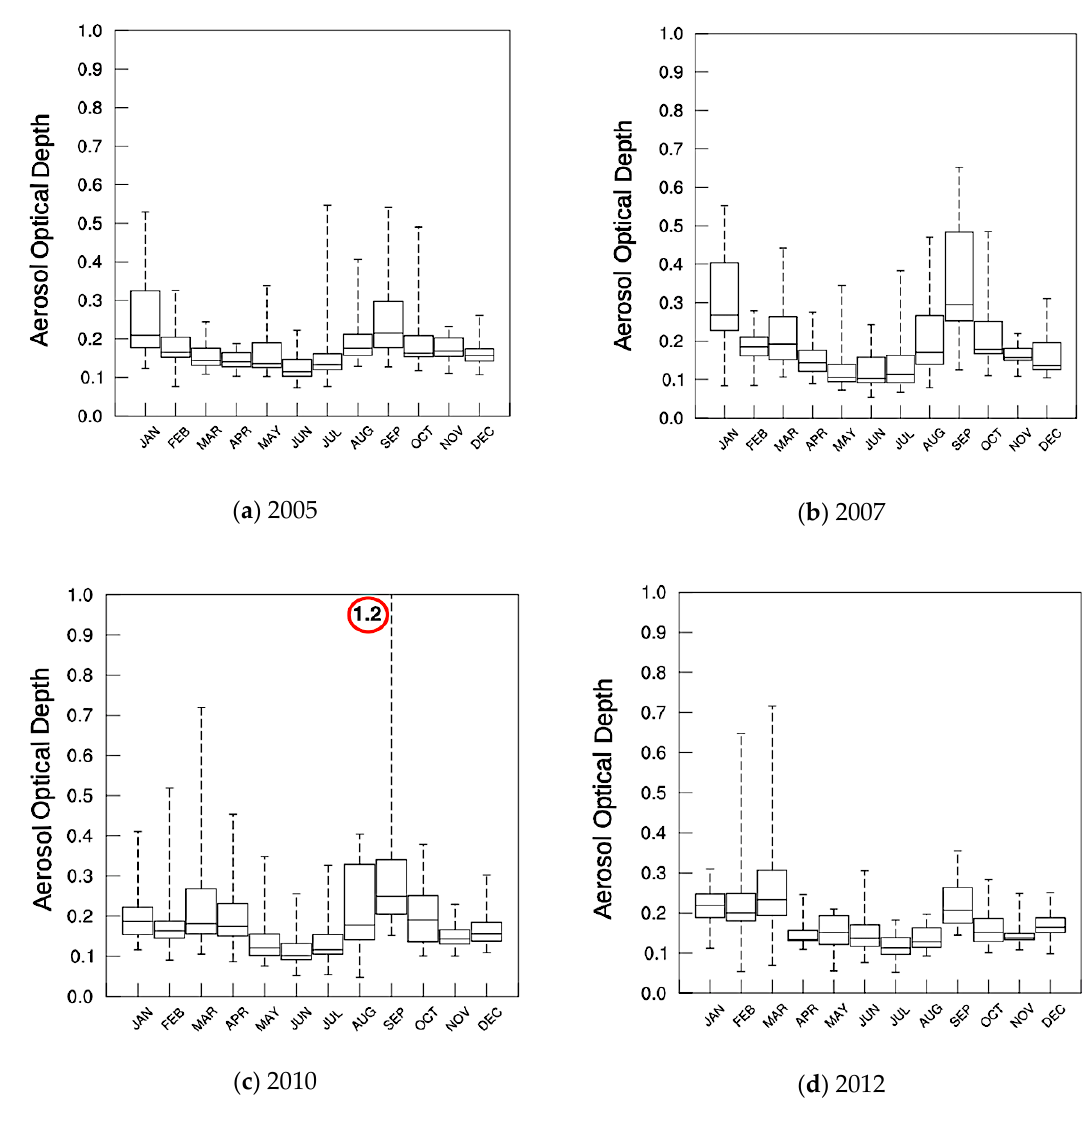
Figure 3. Box plot of MODIS TERRA and AQUA Aerosol Optical Depth for 2005 ( a ), 2007 ( b ), 2010 ( c ) and 2012 ( d ). The bottom part of the boxes corresponds to the first quartile (Q1), the line in the middle, the median (Q2) and the third quartile (Q3) is represented by the upper part. The flags on each box, correspond to the minimum and maximum values